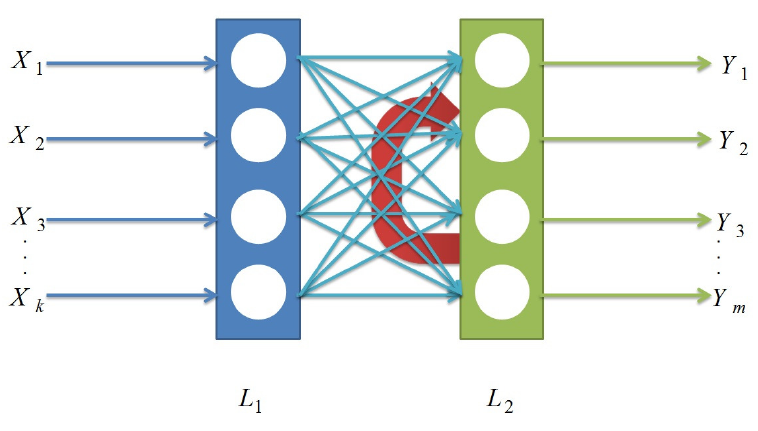
Figure 1. The topology structure of classical hamming neural